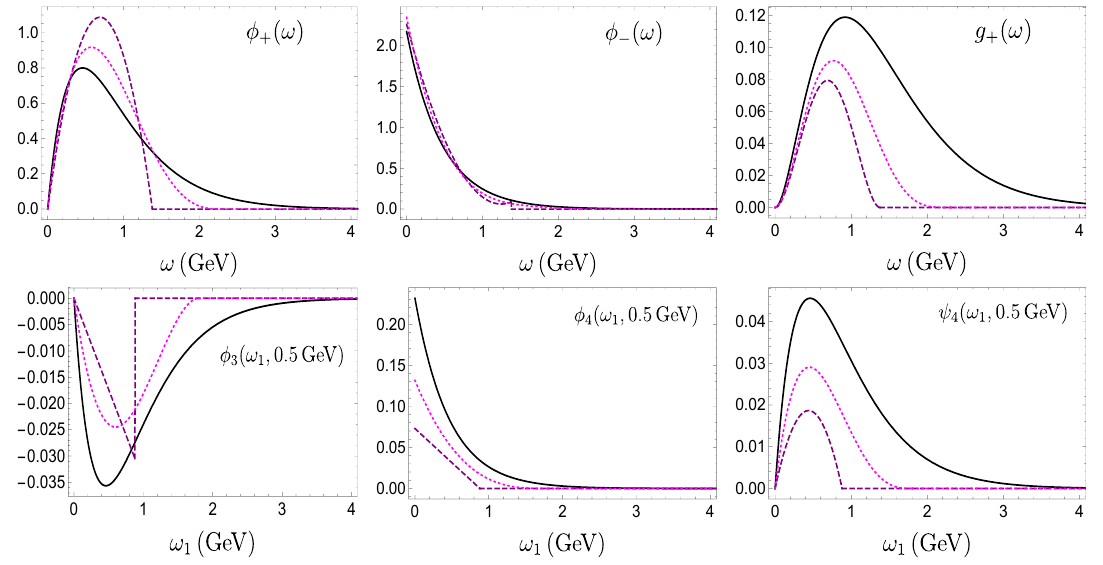
Figure 5 . Two- and three-particle LCDAs within the three di(cid:11)erent models considered: Model I (solid), Model IIA (dashed) and Model IIIA (dotted). These plots are obtained (cid:12)xing (cid:21) B and R to their central values, and ! 2 = 0 : 5